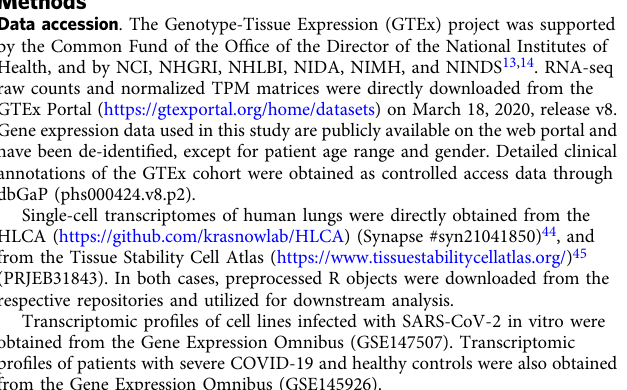
Lung Cell Atlas 44